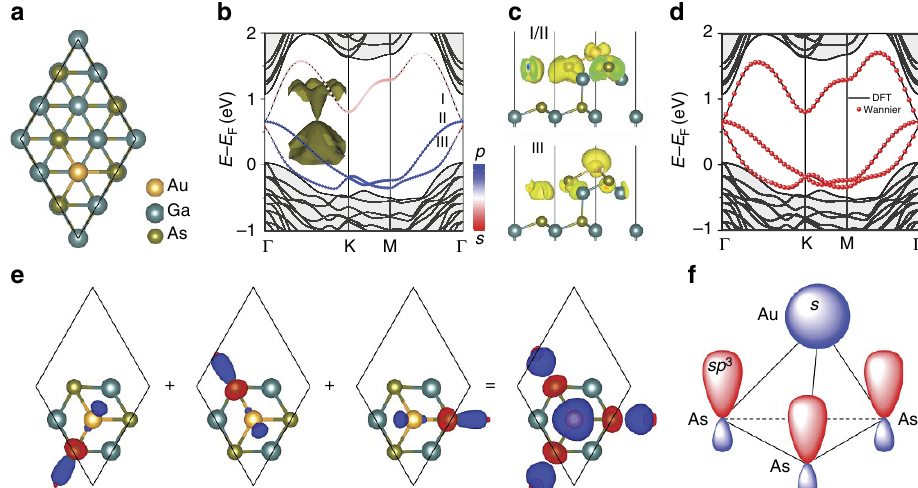
p p R 30 (cid:5) superlattice structure for Au grown on As-terminated Figure 3 | Band and orbital analysis for Au/GaAs(111) without SOC. ( a ) Top view of ffiffiffi 3 (cid:4) ffiffiffi 3 GaAs(111) surface. ( b ) Band structure of Au/GaAs(111) superlattice without SOC. The inset is 3D plotting of I, II and III bands around G point. The red and blue colours indicate the component of s and p orbitals, respectively. ( c ) Charge density distribution of I, II and III bands at G point, showing the surface character. ( d ) Comparison between density functional theory (DFT) bands (solid lines) and MLWFs fitted bands (red dots). ( e ) Top view of three MLWFs fitted from the DFT bands and the overall orbital shape by adding them together. Red and blue colours denote positive and negative value, respectively. ( f ) Schematic view of the un-hybridized orbitals. One s orbital for Au and three sp 3 orbitals for three As atoms, forming a tetrahedron structure. For clarity, only Au and the top two (one) bilayer GaAs atoms are plotted in c , e